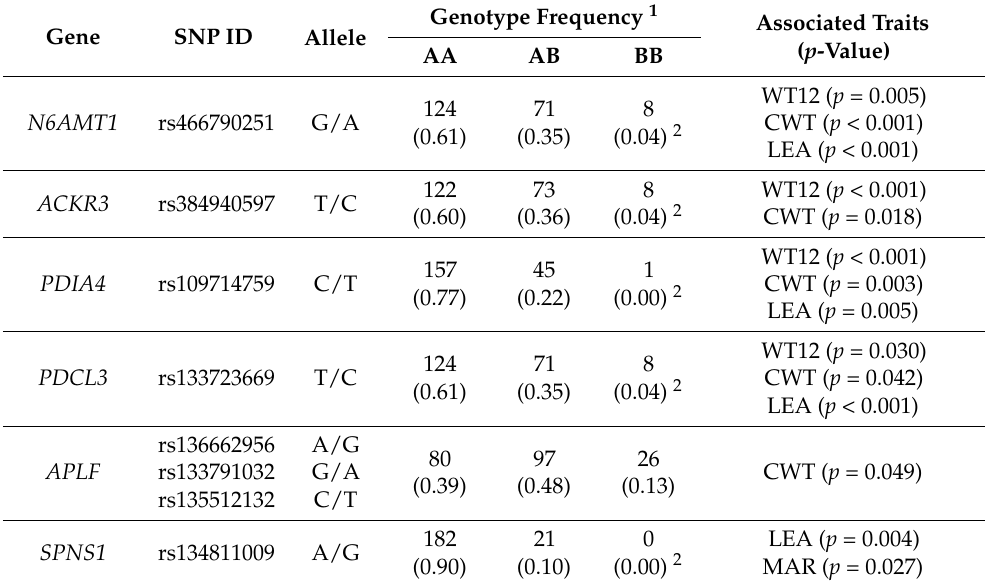
Table 2. Effects of MAE SNPs on breeding values of traits measured in Hanwoo. Genotype Frequency 1 Associated Gene SNP ID Allele